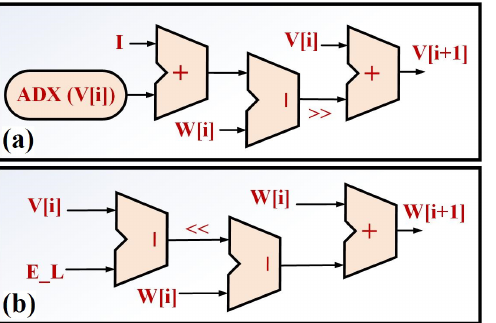
Figure 4. General architecture of the proposed model. ( a ) Proposed structure of the voltage variable. ( b ) Proposed structure of the recovery